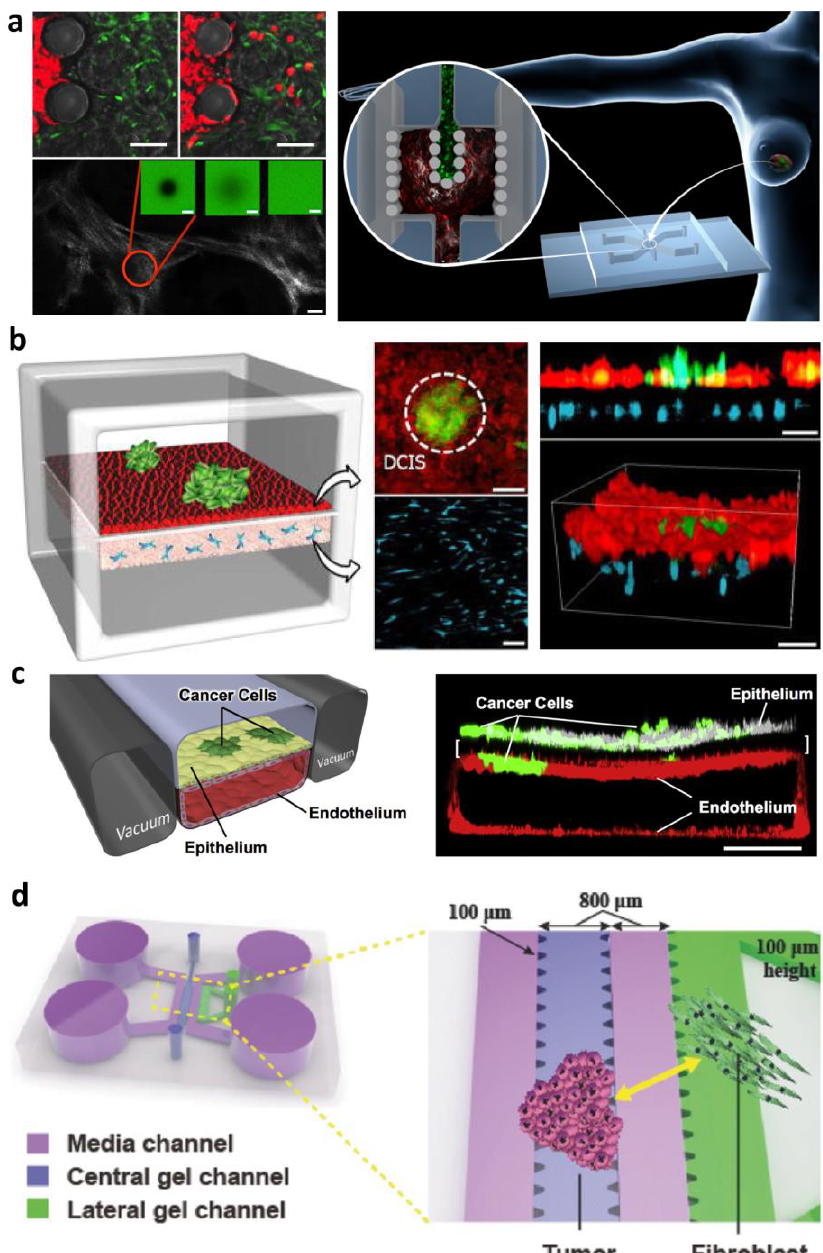
Figure 3. Cancer on chip for modeling tumor–stroma interaction: ( a ) On-chip activation of stromal tissue by crosstalk with cancerous tissue. The compartmentalized device is designed for accommo- dating stromal tissue and epithelial tumor tissue allowing microtissues physical contact, across the separation formed by the pillars, in order to replicate the tissue–tissue interface. SHG and FRAP techniques were used to investigate transport properties and remodeling of neo synthesized ECM and time-lapse images at fluorescence microscopy were used to detect the migration of MCF7 cells from the tumoral chamber to the stromal chamber. Reproduced with permission [92]. Copyright 2016, John Wiley and Sons. ( b ) Breast-cancer-on-a-membrane chip to replicate the early stages of breast cancer enabled the co-culture of multicellular ductal carcinoma in situ (DCIS) spheroids with normal epithelial cells close to human mammary fibroblasts embedded in a 3D ECM matrix. The DCIS spheroids were injected into the upper channel and adhered to the epithelial cell surface inte- grating into the epithelium. Reproduced from [14] with permission from The Royal Society of Chemistry. ( c ) Small airway membrane organ chips for orthotopically injecting a human non-small- cell lung cancer (NSCLC) line within the primary alveolus to recapitulate organ microenvironment-